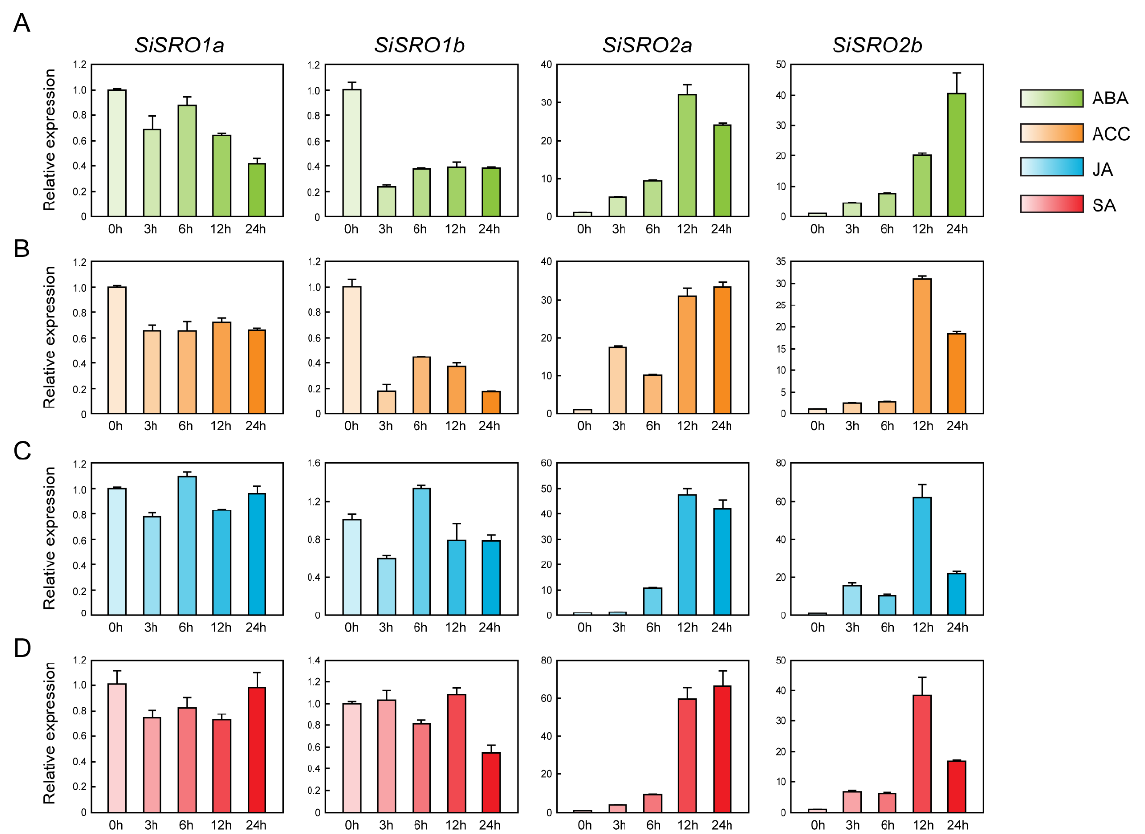
Figure 7. Expression profiles of the SiSRO genes in response to various phytohormone treatments. ( A–D ) Expression of SiSRO genes responses to ( A ) 100 µ M abscisic acid (ABA), ( B ) 100 µ M 1-aminocyclopropane-1-carboxylic acid (ACC), ( C ) 100 µ M jasmonic acid (JA), and ( D ) 100 µ M salicylic acid (SA). Two-week-old seedlings were treated with different phytohormone treatments. Relative expression levels of SiSRO genes were analyzed by qRT-PCR, using sesame SiH3.3 gene as the internal control. Error bars indicate standard deviations (SD) based on three replicates.